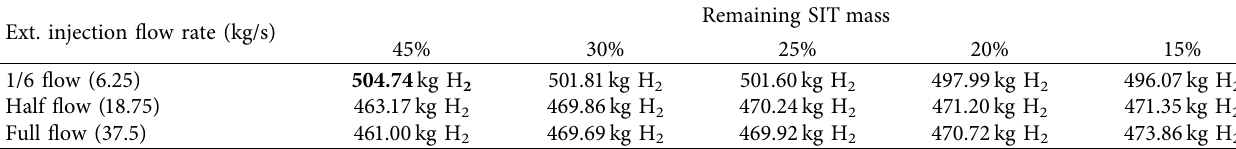
Table 11: Effect of injection timing on H 2 generation (depressurization at core melting).